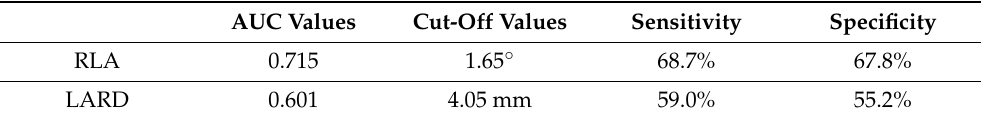
Table 4. Results of ROC curve